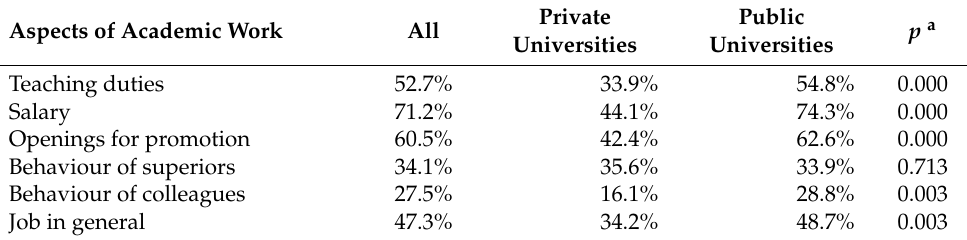
Table 1. Relative number of individuals that report a loss of job satisfaction regarding five aspects of their job and regarding their job as a whole since